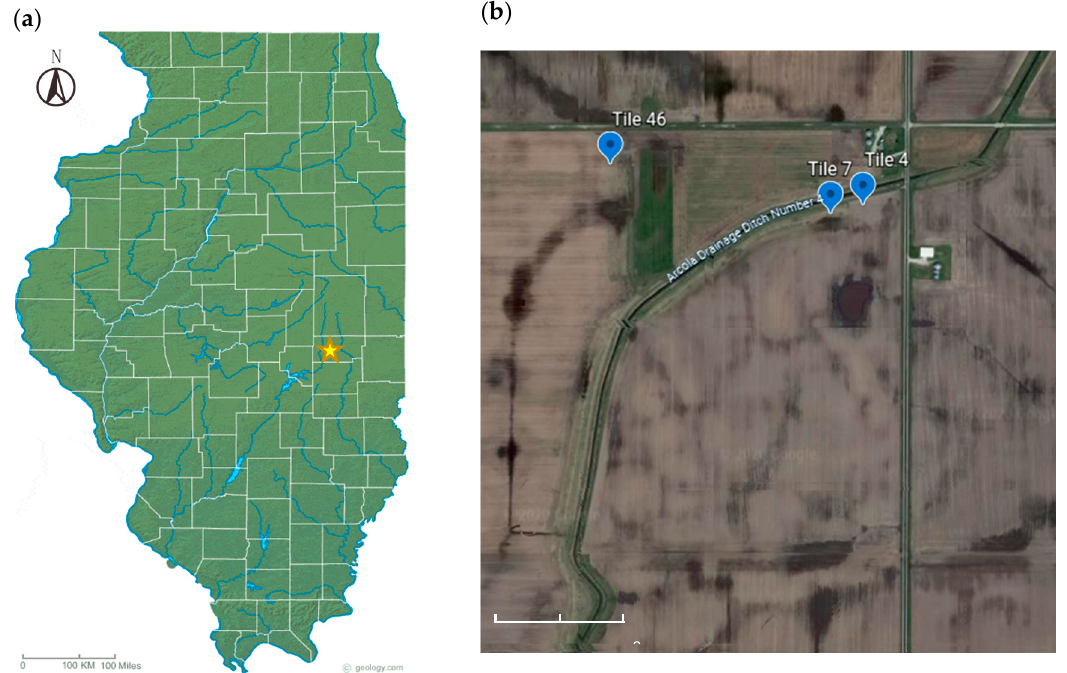
Figure 1. ( a ) Location of the study site in Douglas county, Illinois. Cited from https: // geology.com / topographic-physical-map / illinois.shtml. ( b )AsatelliteimageoftheDRPmonitoringsite(39 ◦ 43 (cid:48) 27.5 (cid:48)(cid:48) N 88 ◦ 13 (cid:48) 56.8 (cid:48)(cid:48) W) obtained from Google